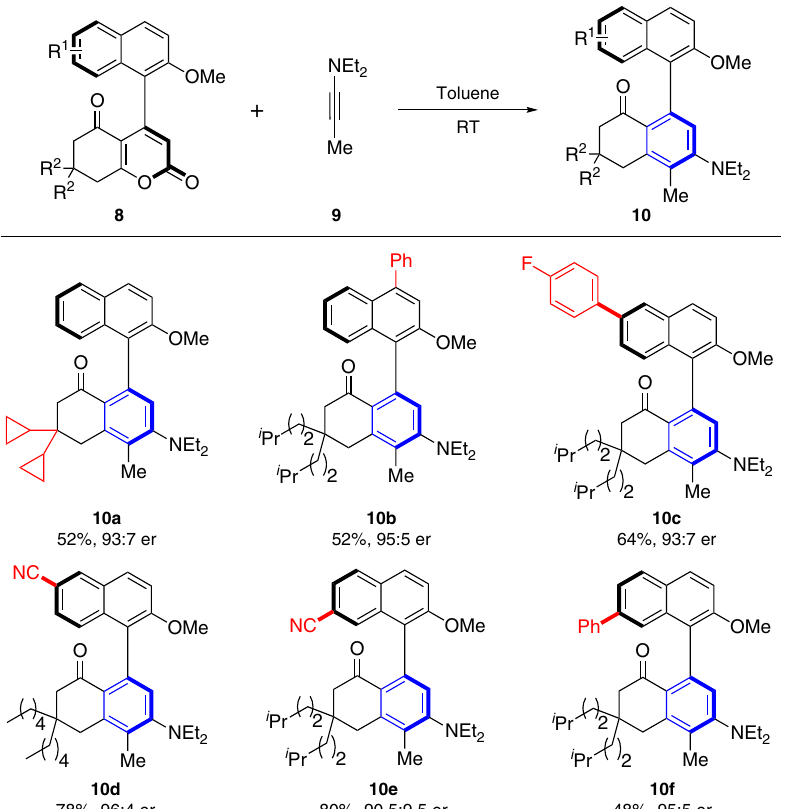
Fig. 5 Scope of Diels – Alder reaction. Reaction conditions: a mixture of 8 (0.1 mmol), 9 (1.0 mmol), in toluene (2.0 mL) was stirred at room temperature for 72